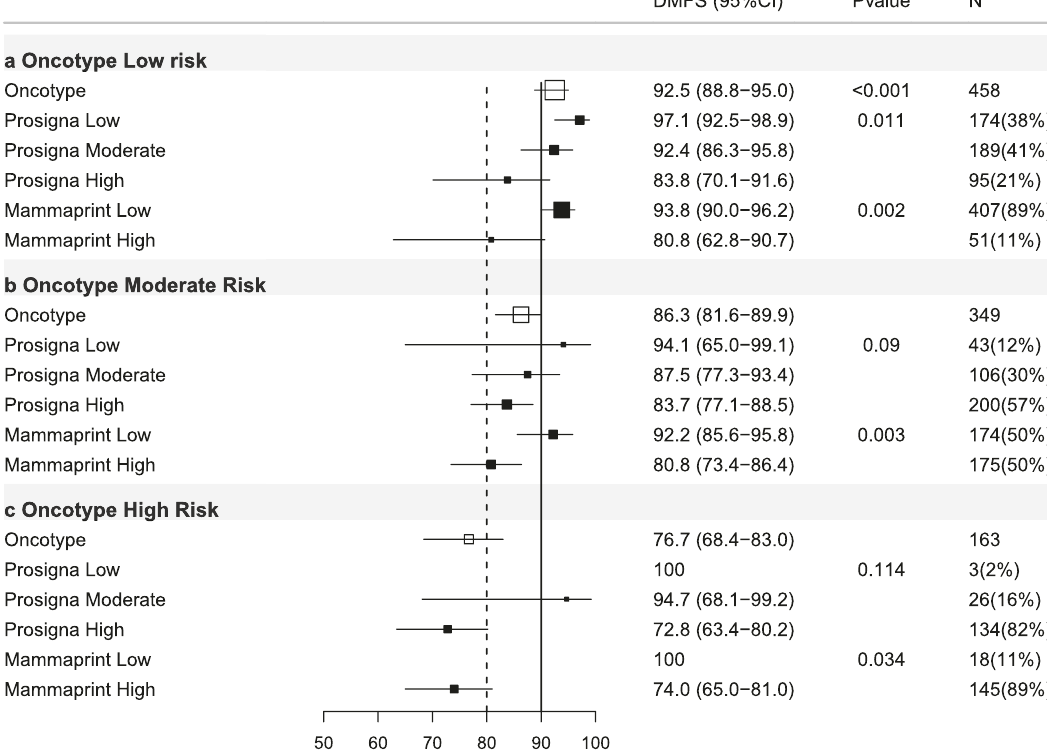
Fig. 5 Forest plot of Oncotype-trained test results re-strati fi ed by other tests, Node-ve ER + ve/HER2-ve cases treated without chemotherapy. DMFS10 = distant metastasis free survival at 10 years post diagnosis. (95% CI) = 95% con fi dence interval, P = p value, N = number of cases in each subgroup, % = percentage of cases within each risk strata. X axis = percent distant metastasis free survival. Open boxes represent primary test DMFS10 by risk group. Solid boxes represent sub-strati fi cation by secondary tests with 95% con fi dence intervals (bars). Top panel ( a ) Oncotype-trained low-risk cases strati fi ed by Prosigna-trained and Mammaprint-trained results. Middle panel ( b ) Oncotype-trained moderate risk group. Bottom panel ( c ) Oncotype-trained high-risk